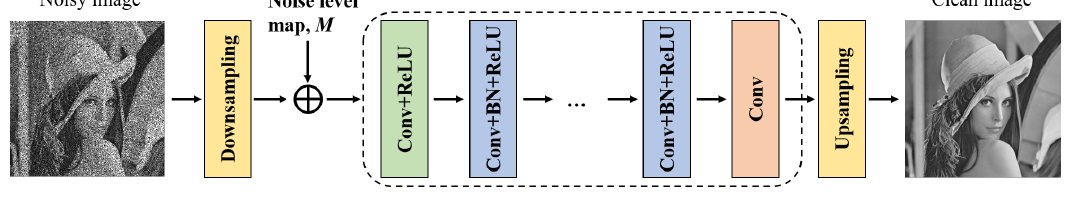
Figure 1. The architecture of FFDNet